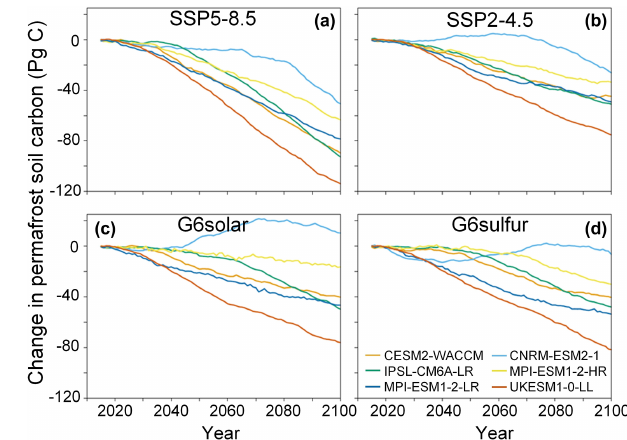
Figure 6. Cumulative change in circum-Arctic permafrost C stor- age obtained from modified PInc-PanTher driven by TSL, NPP, and RPE simulations. Simulations are performed under the SSP5-8.5, SSP2-4.5, G6solar, and G6sulfur scenarios up to the year